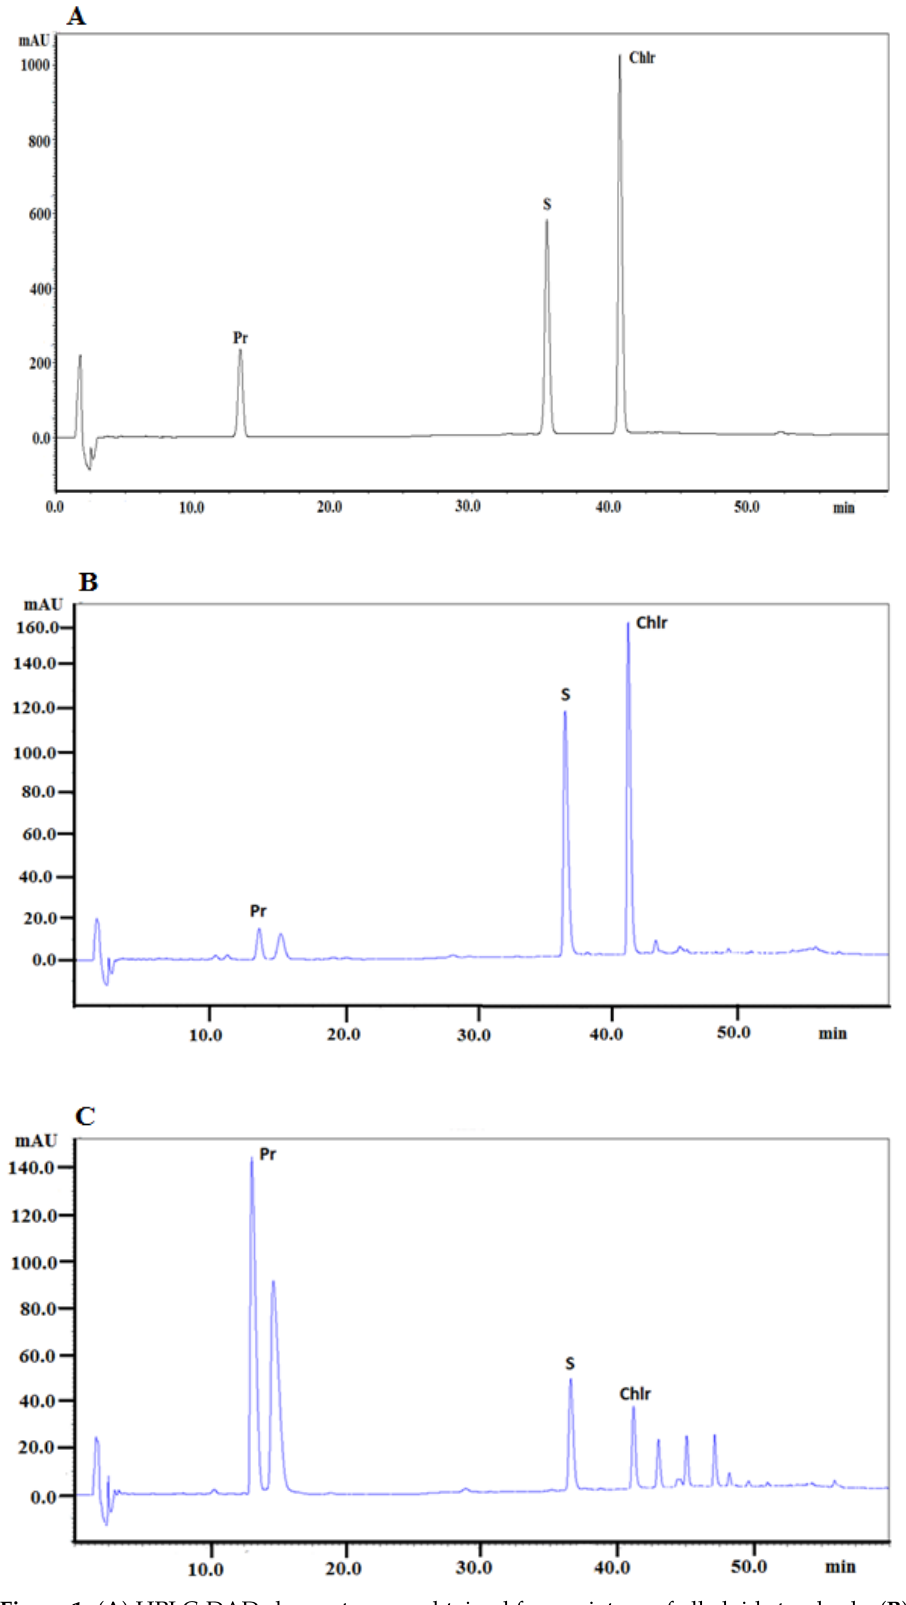
Figure 1. ( A ) HPLC-DAD chromatogram obtained for a mixture of alkaloid standards, ( B ) HPLC- DAD chromatogram obtained for the extract from the Macleaya cordata aerial part collected in May, ( C ) HPLC-DAD chromatogram obtained for the extract from the Macleaya cordata root collected in May. Chlr: chelerythrine; Pr: protopine; S: Ssnguinarine. The acquisition wavelength was set at 240